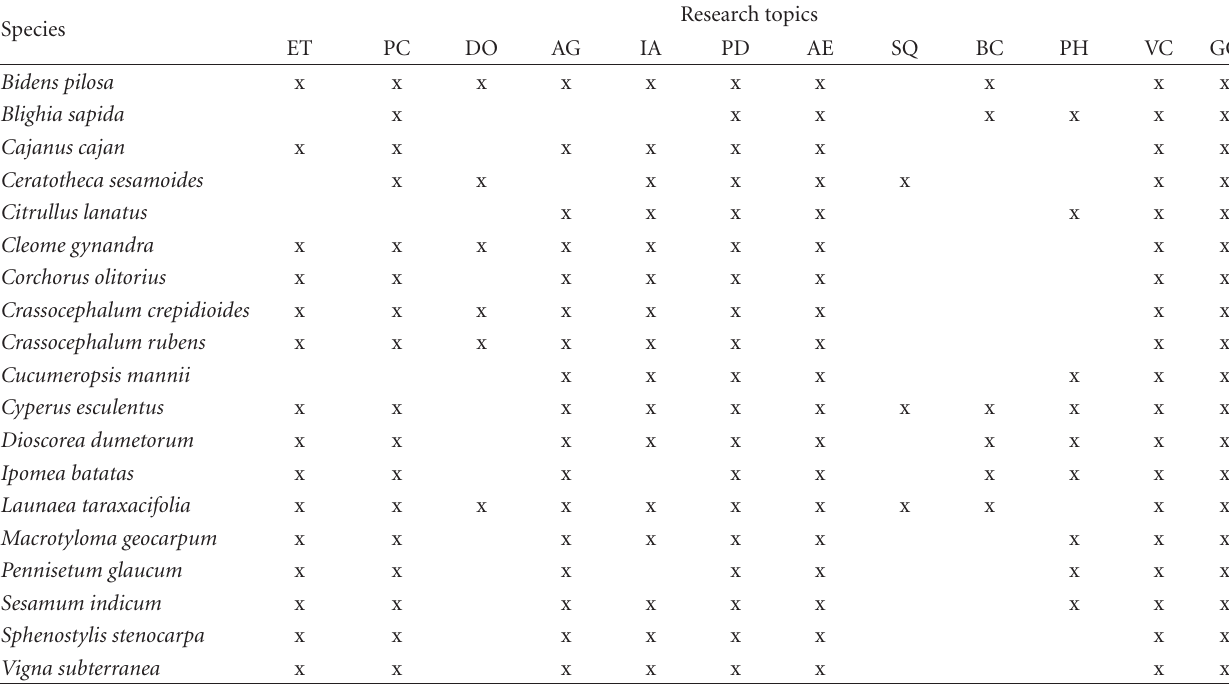
Table 8: Research needs on the priority neglected and underutilised crop species of Benin. Species